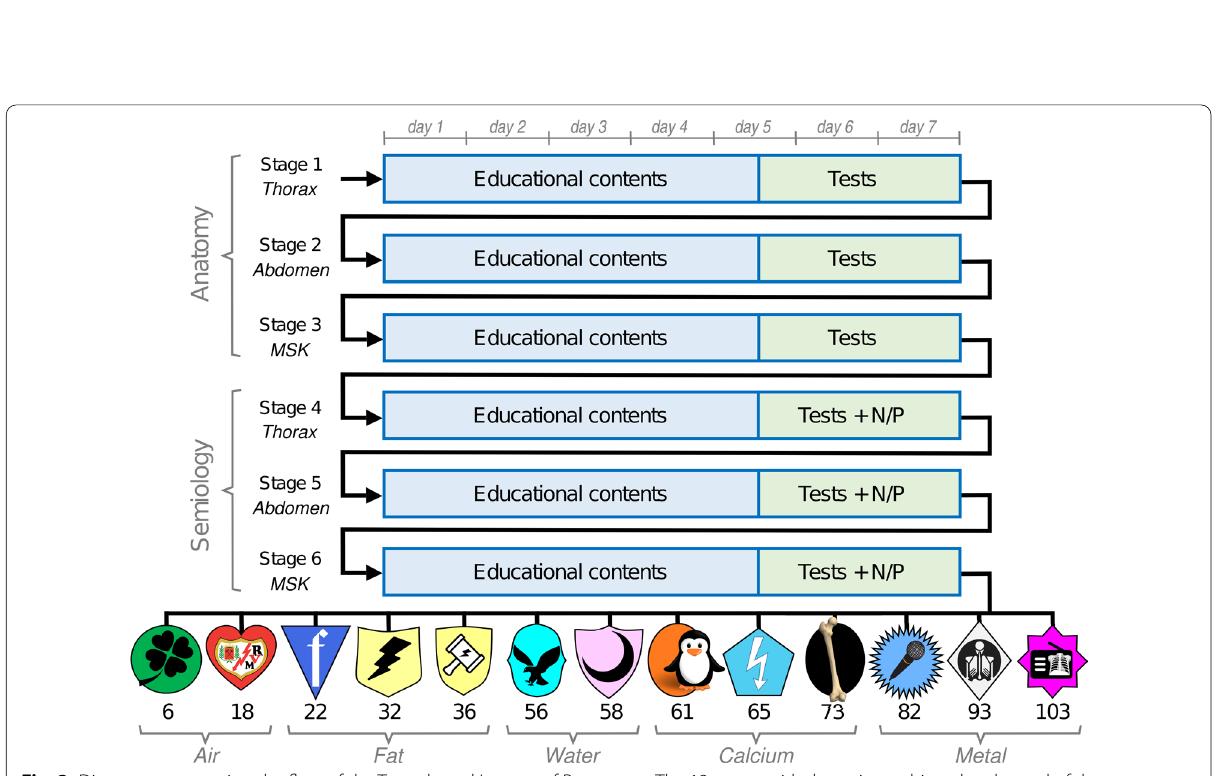
Fig. 3 Diagram representing the flow of the Team‑based League of Rays game. The 13 teams with the points achieved at the end of the competition are shown below, together with the badge that represents them. Test: Multi‑choice test of 15 questions. N/P: Task "Normal or